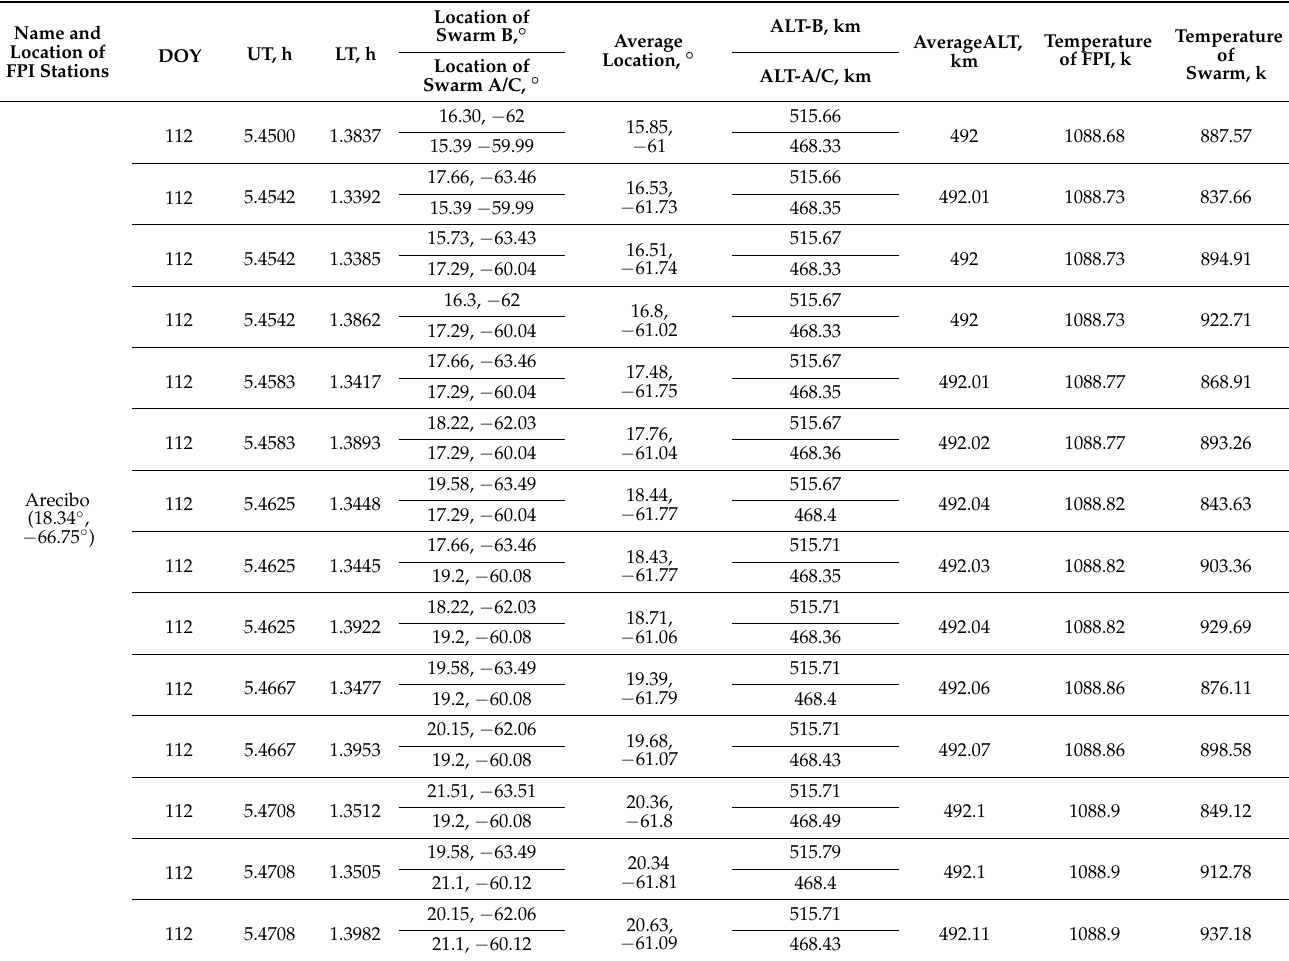
Table A1. Comparative data of inversion temperature and FPI temperature calculated with m 0 in